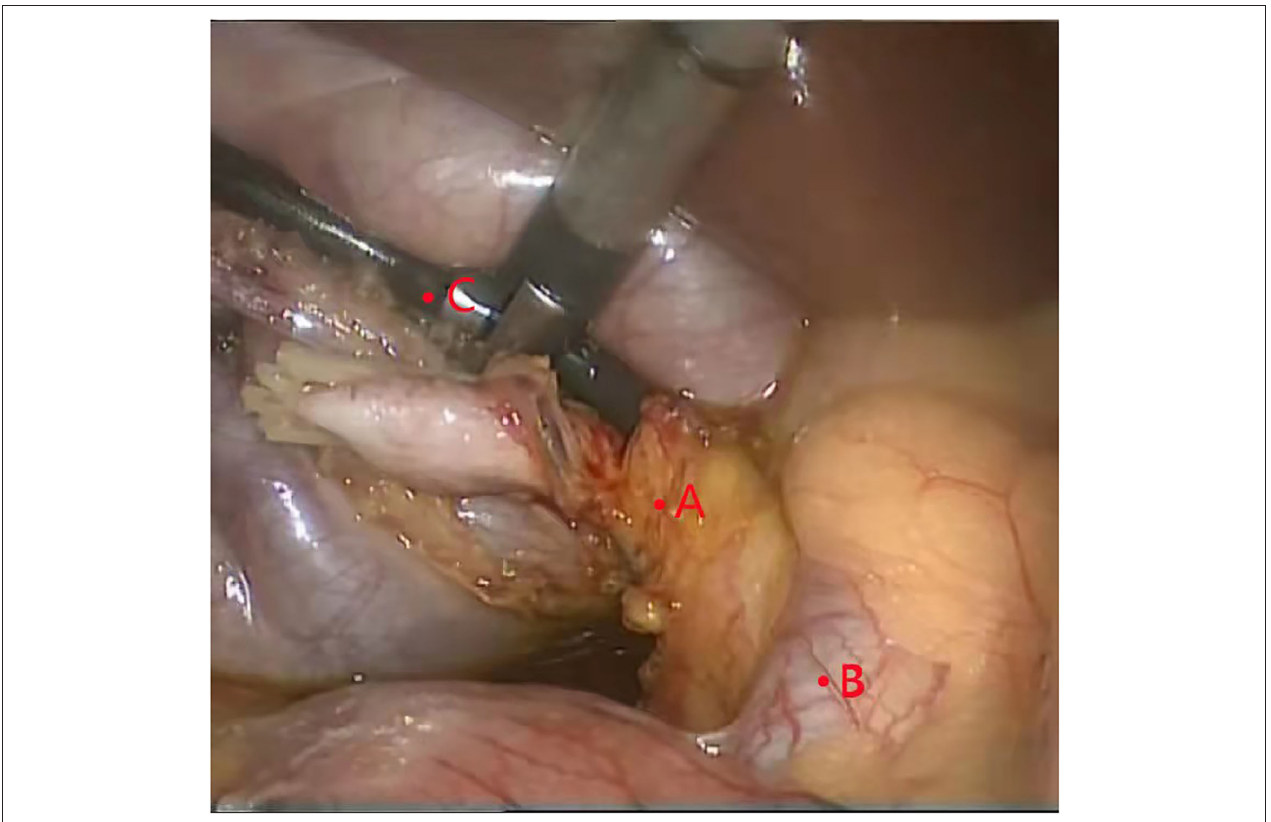
FIGURE 2 | Using ultrathin choledochoscope to remove broken stones. (A) cystic duct. (B) common bile duct. (C) ultrathin choledochoscope.